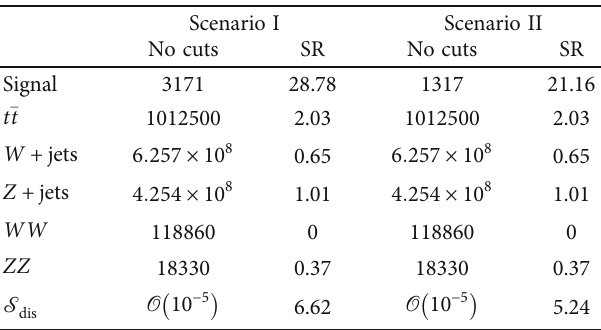
Table 4: Number of signal and background events at for an integrated luminosity of L = 100 fb − 1 before and after applying cuts. The last line represents the signal signi fi cance obtained using Equation